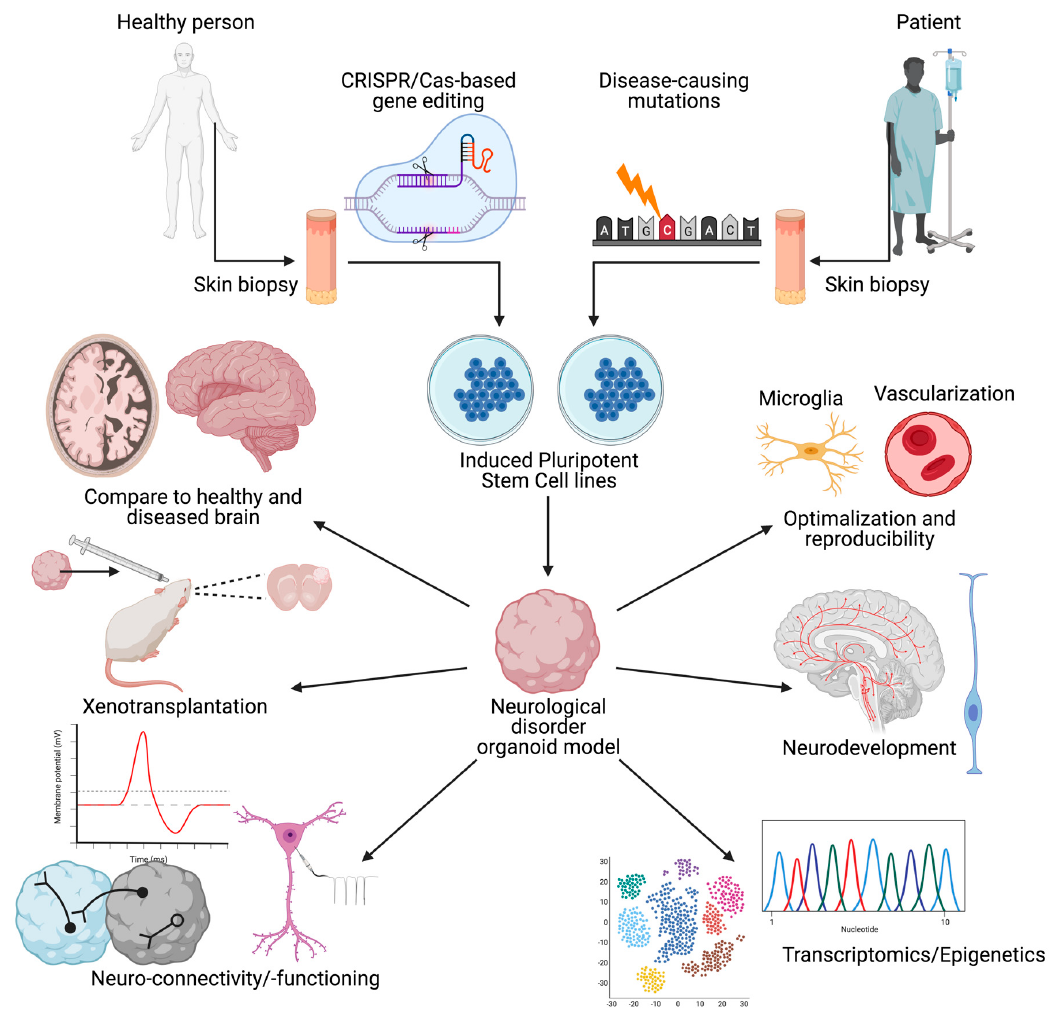
Figure 1. A schematic overview of the creation of and uses for organoid models of neurological disorders. Overview of the different research outcome measures and tools available to researchers working with brain